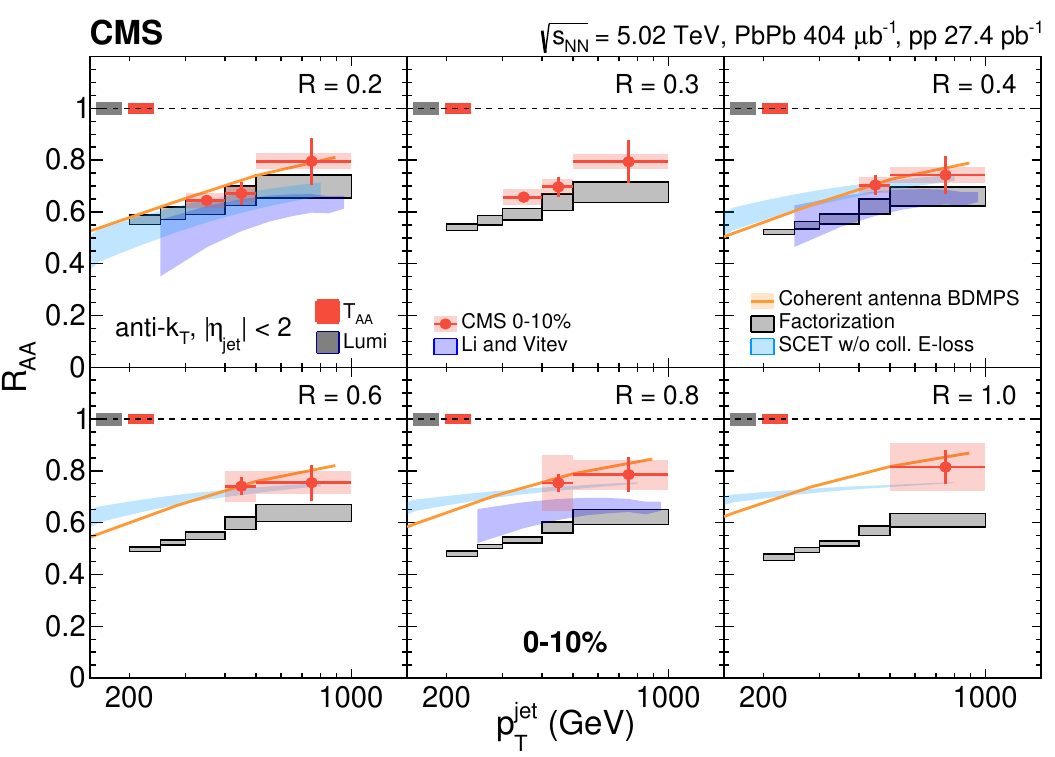
for jets with | η jet | < 2 . 0 , as a function of p jet , for various R values and Figure 13 . The R AA T 0–10% centrality class. The statistical uncertainties are represented by the vertical lines, while the systematic uncertainties are shown as the shaded boxes. The markers are placed at the bin centers. Global uncertainties (integrated luminosity for pp and h T i for PbPb collisions) are shown as the AA colored boxes on the dashed line at R = 1 and are not included in the shaded bands around the AA points. The calculations from Scet (sky blue and navy blue), coherent antenna bdmps (orange) and jet factorization (gray) formalisms are compared to the data, shown as the colored boxes and